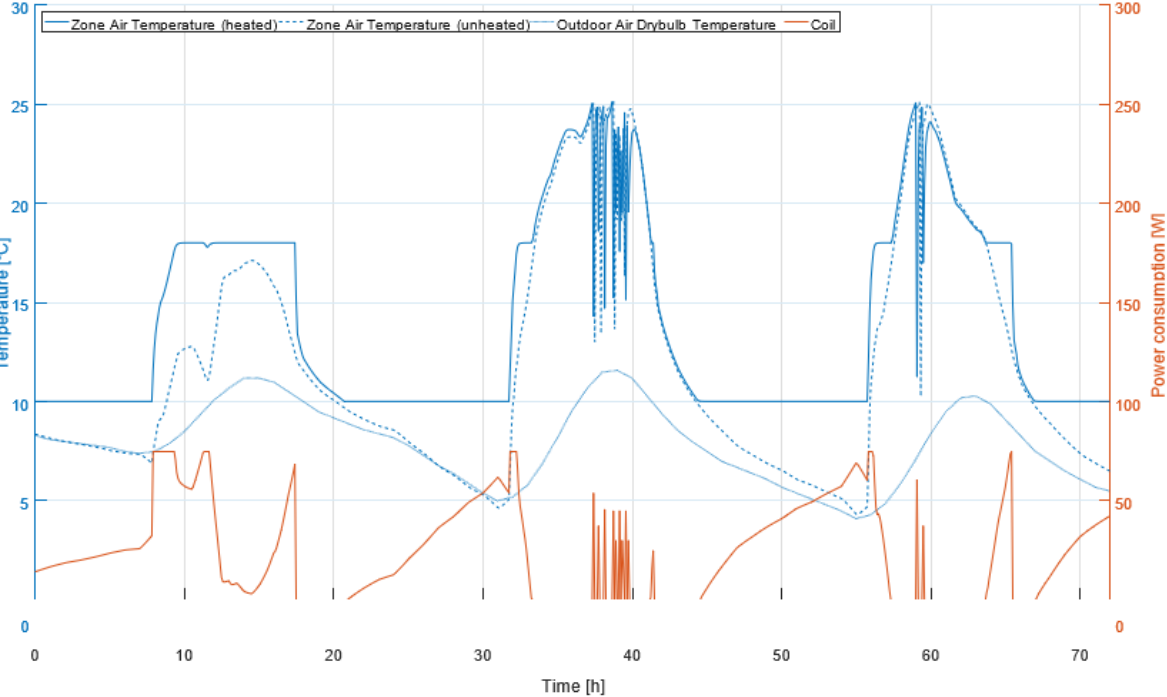
Figure 13. Unheated, heated and outside temperatures of the greenhouse between the 29 and 31 January.